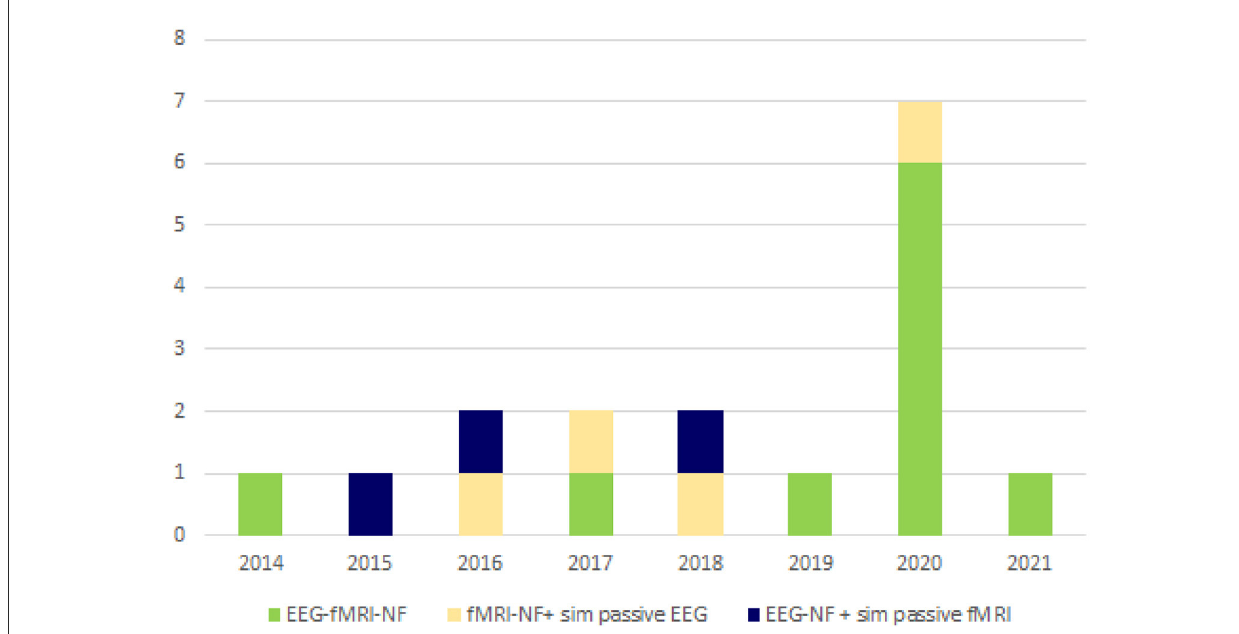
FIGURE3 Distribution over the years of EEG-fMRI-NF studies. EEG-fMRI-NF research began surging in 2014; primary research continues to rise. This graph presents the composition of the publications found in our literature search. NF, neurofeedback; EEG, electroencephalograph; fMRI, functional magnetic resonance imaging.